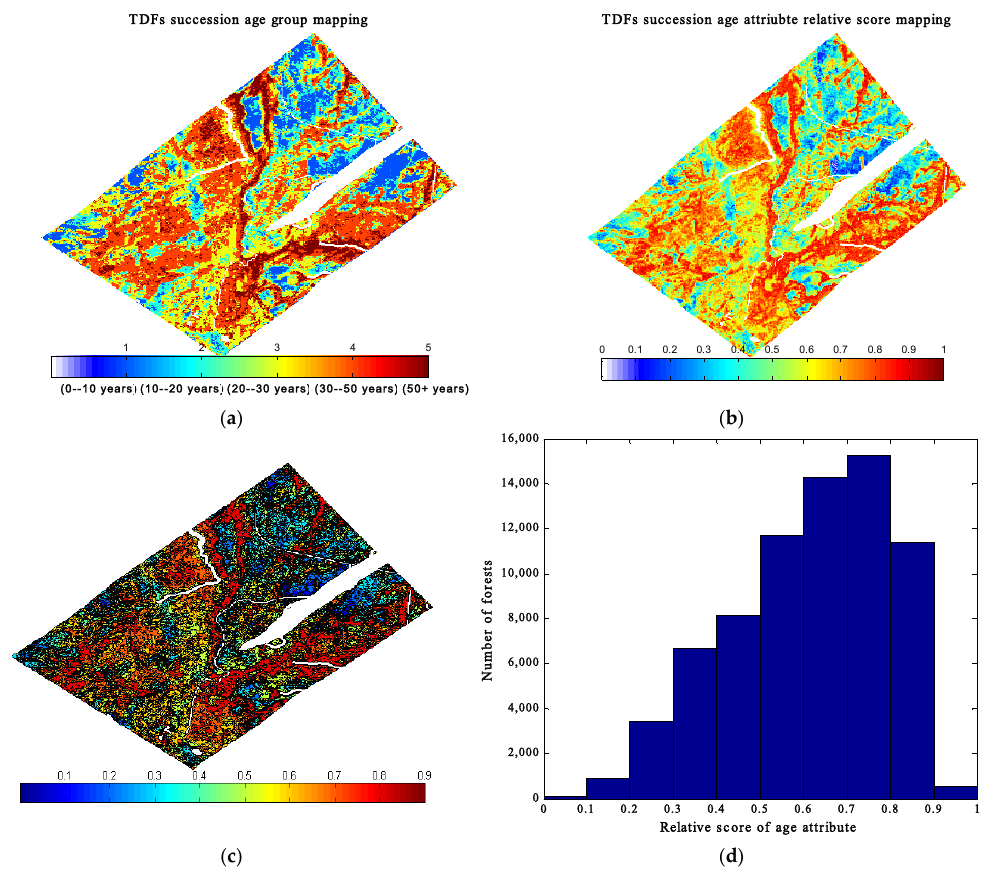
Figure 10. TDFs succession mapping for the whole study area at SRNP-EMSS with respect to the age group ( a ), age attribute ( b ), filled contour map of the relative scores corresponding to the age-attribute mapping ( c ), and statistical histogram